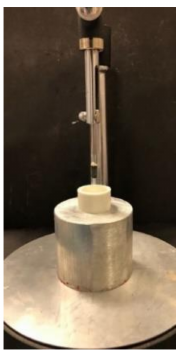
Figure 1. Implant placed in a resin block using a dental